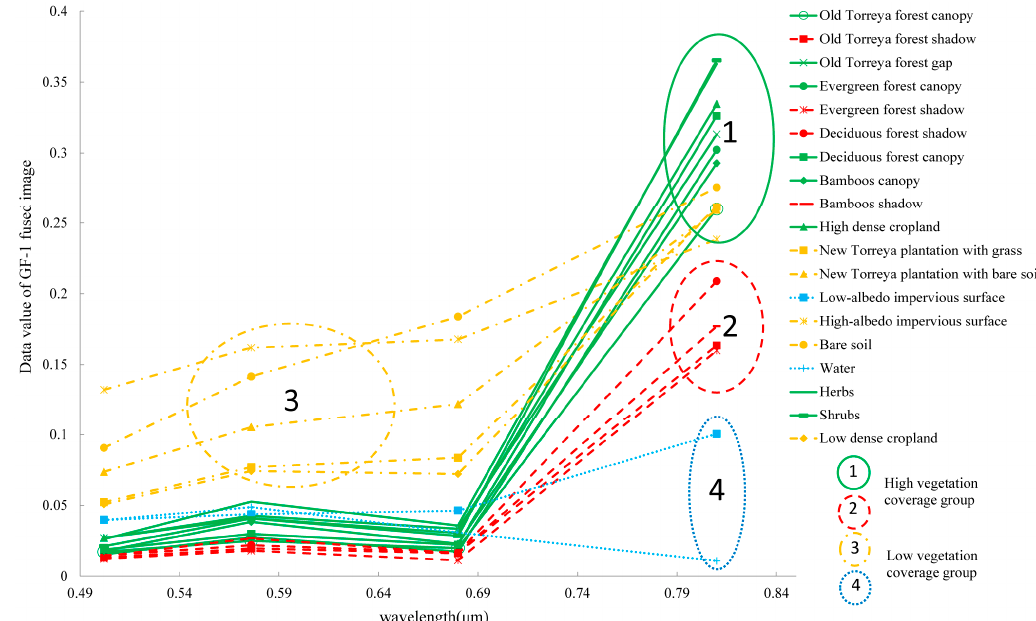
Figure 4. Spectral values of training samples of different land-cover classes.